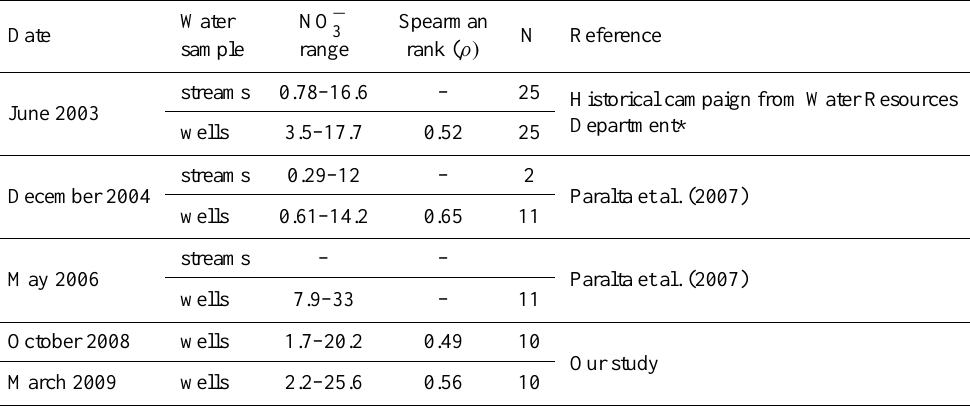
Table 2. Historical levels (mgNl − 1 ) and the Spearman’s Rho coefficient ( ρ ) between measured nitrate concentrations in shallow groundwa- ter and the proportion of water from the space projection of